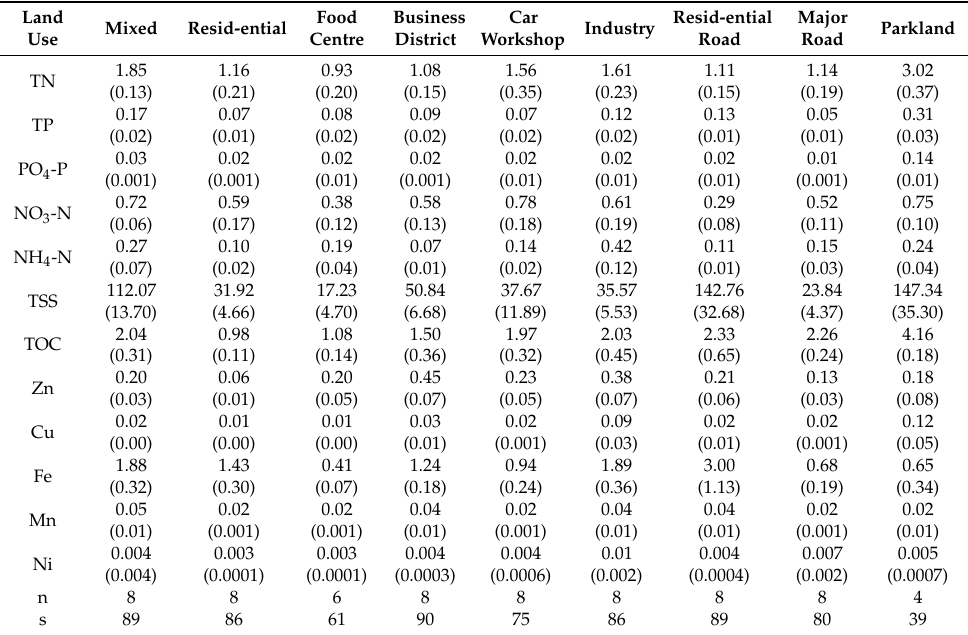
Table 1. The average of the event mean concentrations (EMCs) for water quality